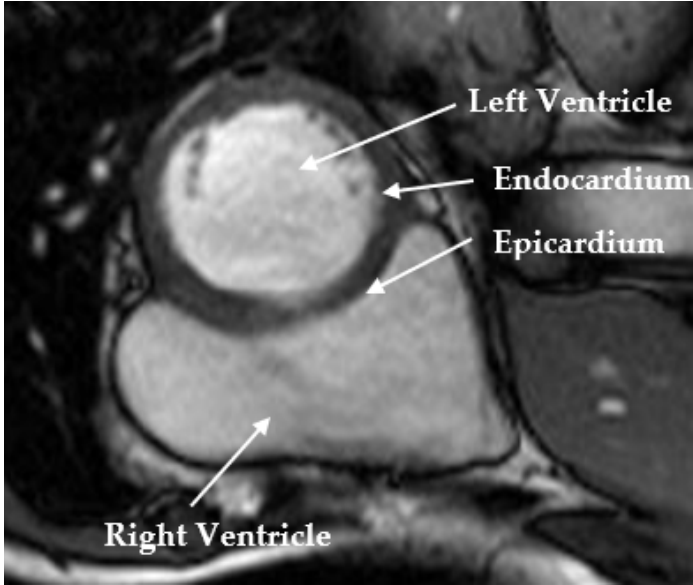
Figure 1. Short-axis cardiac MR anatomy image.